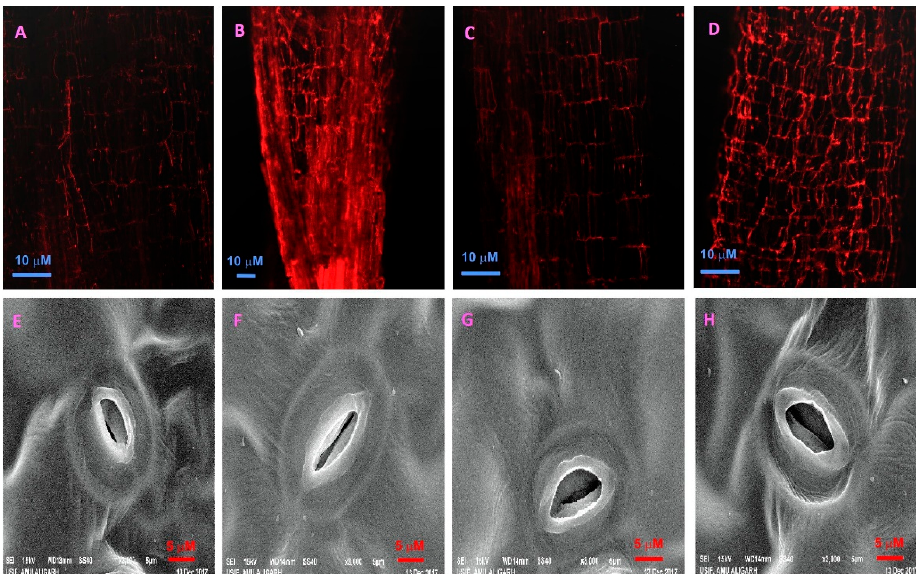
Figure 7. ( A – D ) Cell viability test of roots cells and ( E – H ) leaf stomatal response of Brassica juncea cv. Girira under ( A , E ) control 0 mg Cd kg − 1 soil + 0 mg S kg − 1 soil, ( B , F ) 200 mg Cd kg − 1 soil, ( C , G ) 200 mg S kg − 1 soil, and ( D , H ) 200 mg Cd kg − 1 soil + 200 mg S kg − 1 soil. Bars ( A – D ) = 10 μ M; bars ( E – H ) = 5 μ M.